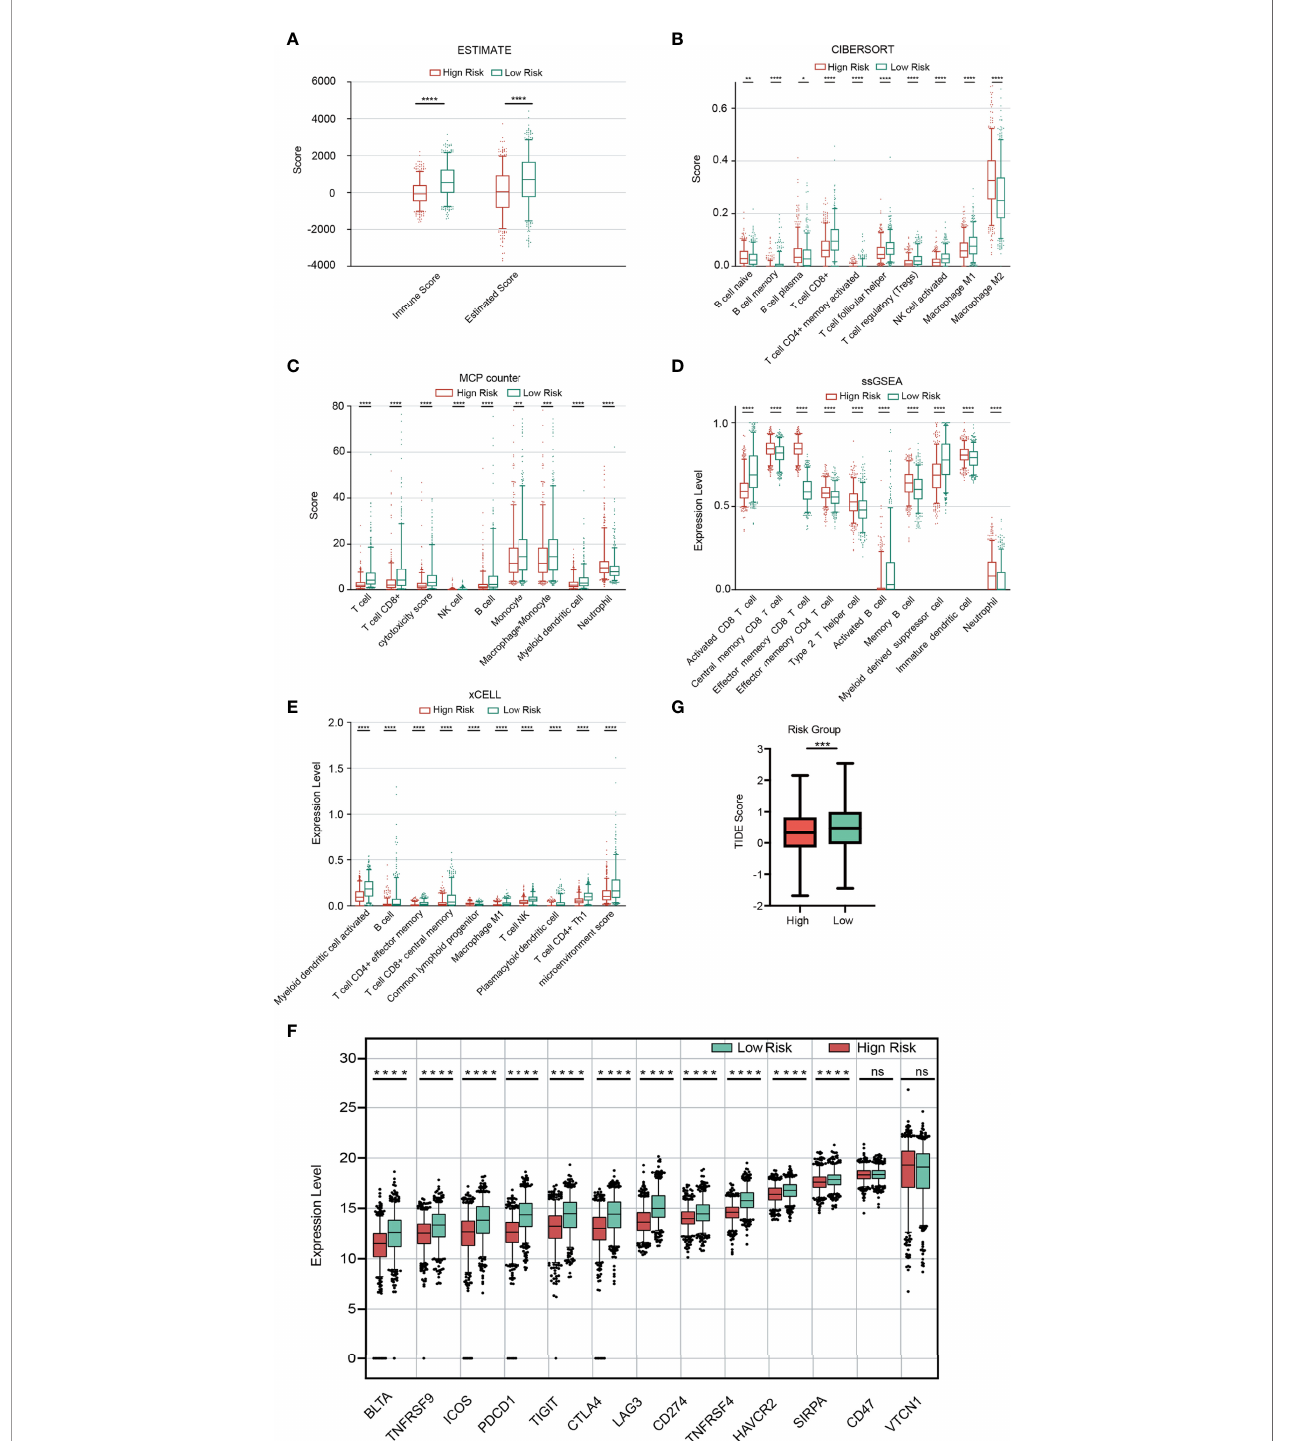
FIGURE 8 | Immune analysis. (A) Comparison of the immune score and ESTIMATE score between the two risk groups. (B-E) Comparison of immune cells between the two risk groups based on Cibersort (B) , MCPcount (C) , ssGSEA (D) and xCELL (E) . Expression distribution of 13 immune checkpoint genes between the two risk groups (F) . TIDE score between the two risk groups (G)